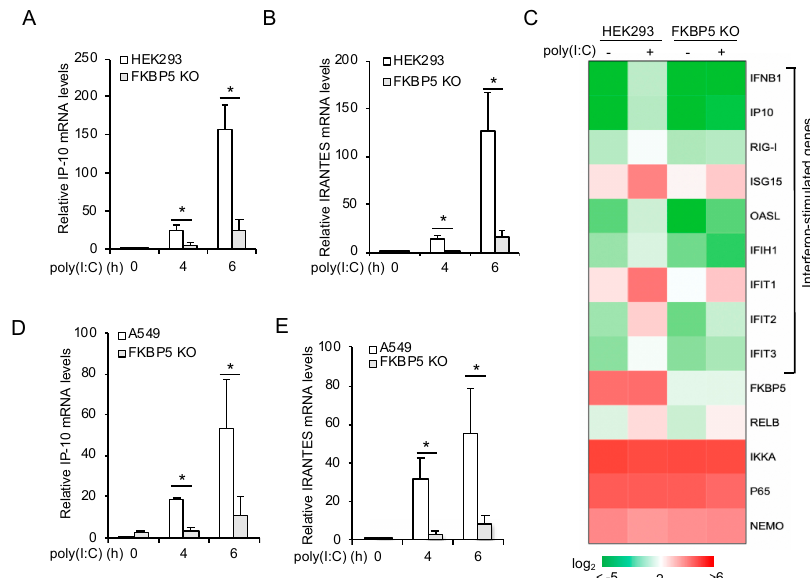
Figure 4. FKBP5 is required for RIG-I signaling. ( A , B ) FKBP5 wild-type and knockout HEK293 cells were stimulated with 1 µg/mL poly(I:C) for the indicated times. Real-time PCR was performed to determine the relative mRNA levels of IP-10 ( A ) and RANTES ( B ). All the experiments were biologically repeated three times. Data represent the means ± S.D. of three independent experiments. The p value was calculated (two-tailed Student’s t -test) by comparison with wild-type cells. An asterisk indicates p < 0.05. ( C ) Heatmap of the RNA sequencing results of wild-type and FKBP5 knockout HEK293 cells stimulated with 1 µg/mL poly(I:C) for 4 h. ( D , E ) FKBP5 wild-type and knockout A549 cells were stimulated with 1 µg/mL poly(I:C) for the indicated times. Real-time PCR was performed to determine the relative mRNA levels of IP-10 ( D ) and RANTES ( E ). All the experiments were biologically repeated three times. Data represent the means ± S.D. of three independent experiments. The p value was calculated (two-tailed Student’s t -test) by comparison with wild-type cells. An asterisk indicates p < 0.05.